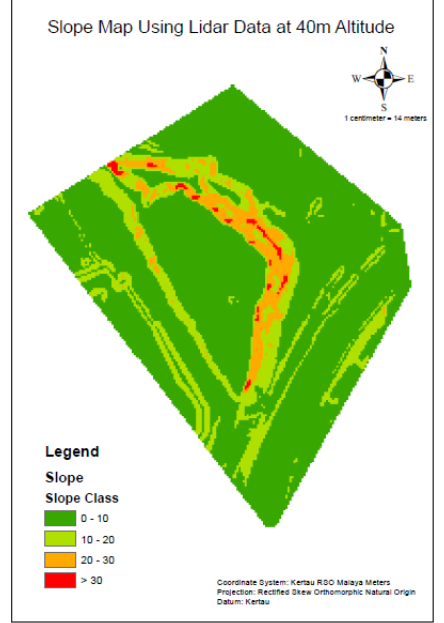
Figure 21. Slope Map Generated Using LiDAR Data at 40m